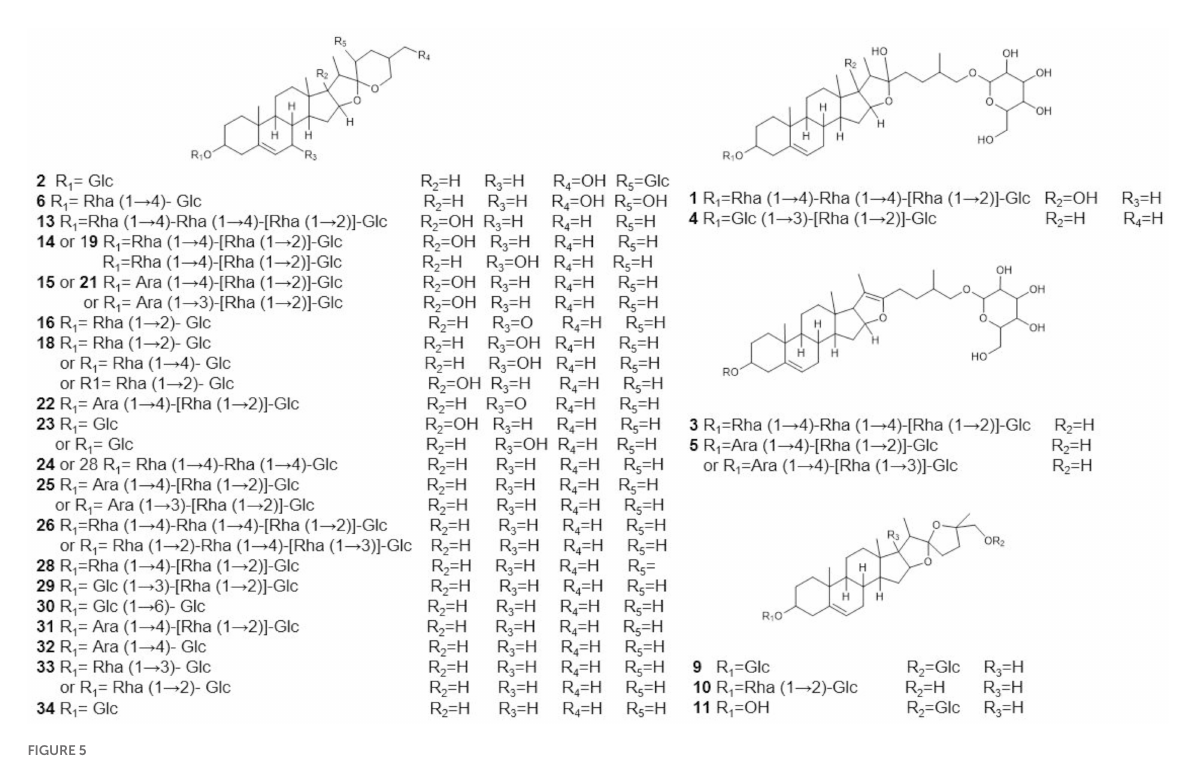
FIGURE 5 Possible structure of labeled saponins based on